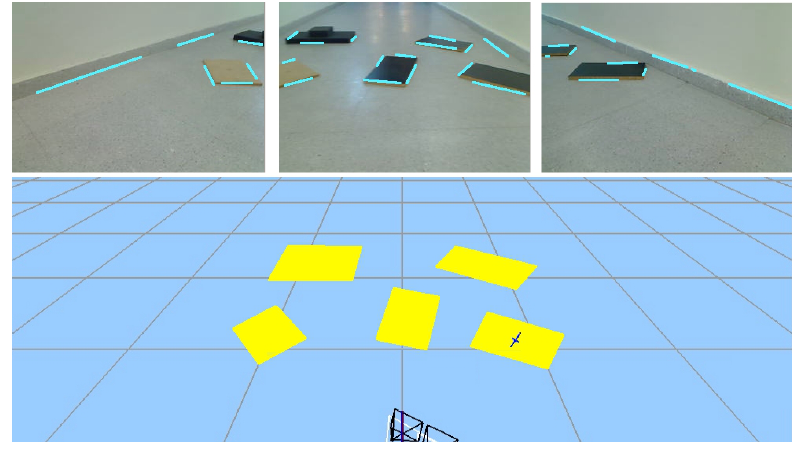
Figure 5. Scene situation with three instantaneous images and 3D scene